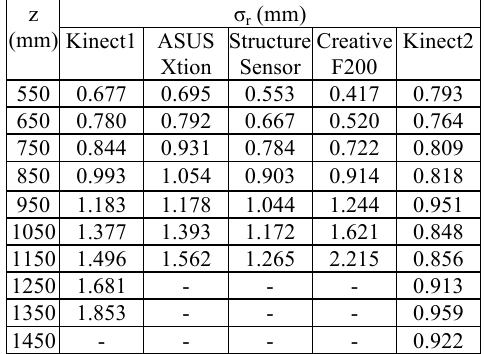
Table 2. Random error (extracted by the raw data as described in section 4.5) vs. distance for the different sensors used in this test.